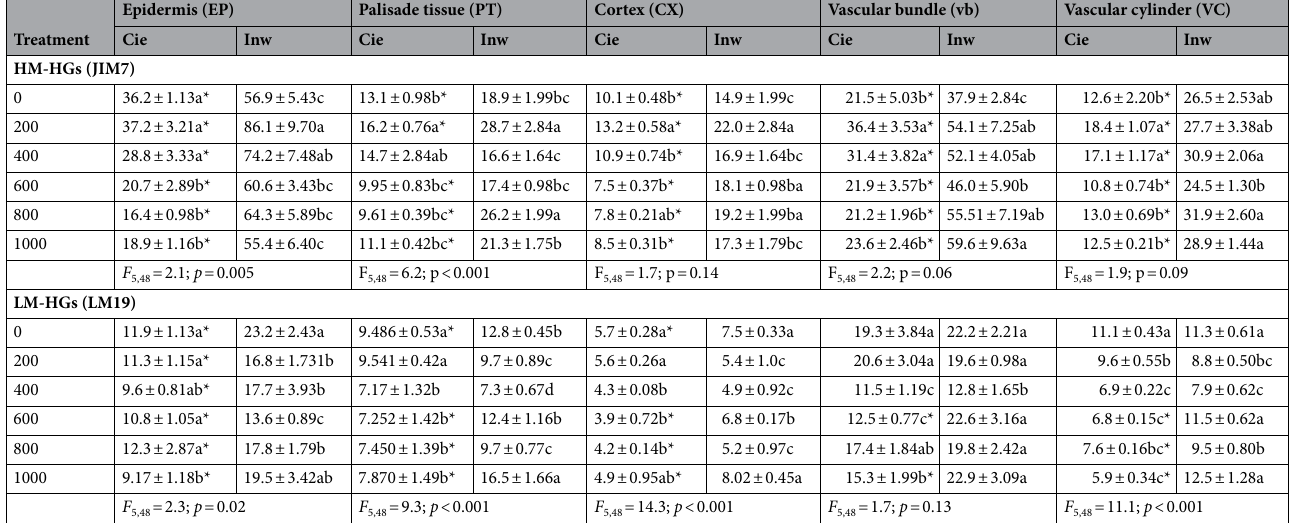
Table 2. Immunofluorescence of S. europaea stem cross-section distribution and quantification of low and high methylesterified homogalacturonans (LM-HGs and HM-HGs) under NaCl stress for two populations (Ciechocinek and Inowrocław). Means and ± SD of replicates. Different letters indicate significant differences between treatments within population and * indicates significant difference between populations within treatment (p < 0.05), n = 5. The F values correspond to the 2-way ANOVA interaction of salt treatment ×